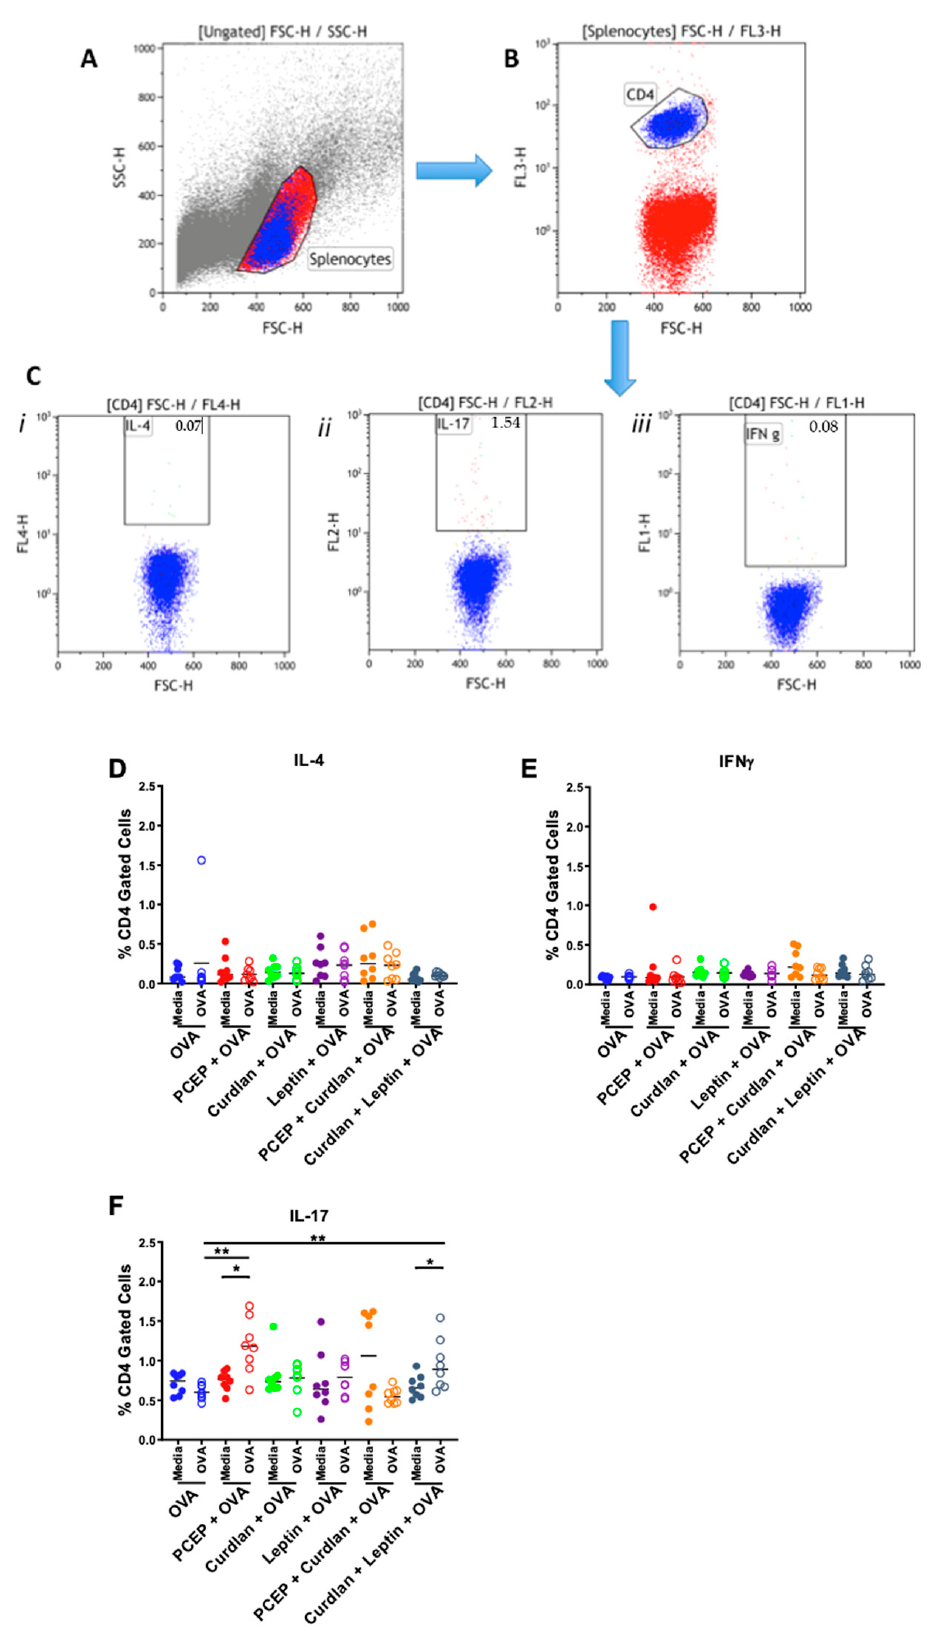
Figure 2. Vaccination with OVA plus PCEP or OVA+Curdlan+Leptin increased the frequency of CD4+IL-17+ T cells in splenocytes. BALB/c mice were mock-immunized or immunized with 50 μ L (25 μ L per leg) of OVA with or without the following adjuvants: PCEP (50 μ g/mL)+OVA, Curdlan (10 μ g/mL)+OVA, Leptin (10 μ g/mL)+OVA, PCEP+Curdlan+OVA, and Curdlan+Leptin+OVA. Booster immunizations were administered on Day 21. Mice were euthanized and spleens were harvested on Day 35 and splenocytes were mock-stimulated with media or restimulated with OVA (1 μ g/mL) and incubated for 48 h. Intracellular flow cytometric gating strategy: FCM was used to identify quantities of different T cell subsets within a spleen cell population from immun- ized BALB/c after 48 h incubation with OVA. ( A ) Portrays the live primary splenocyte gating from total population. ( B ) Portrays the gating of CD4+ cells from within the splenocyte gate. ( C ) Por- trays gating of intracellular cytokines i: IL-4, ii: IL-17, and iii: IFN γ with the CD4+ gate. Data for